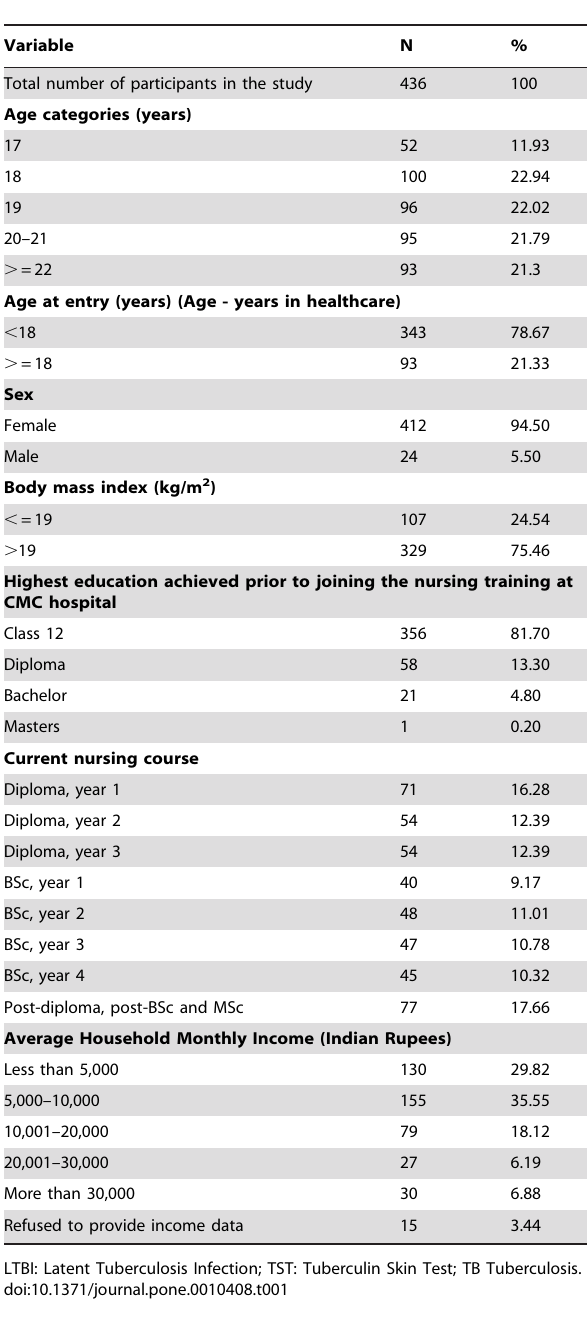
Table 1. Descriptive and demographic characteristics of the participants (N=